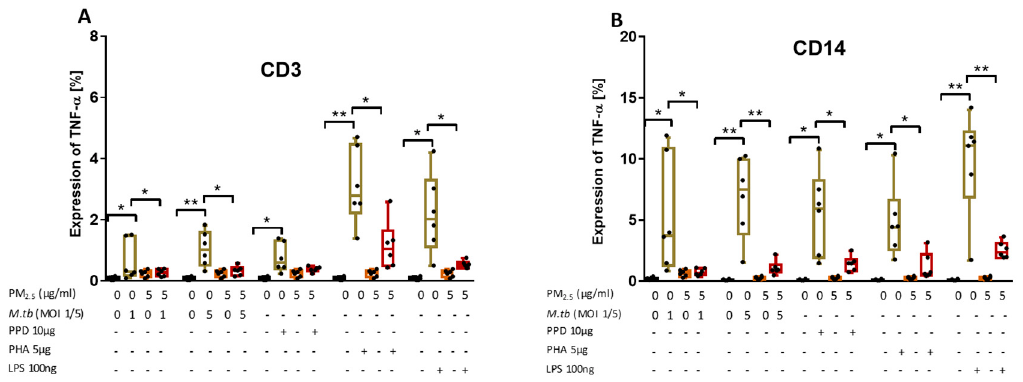
Figure 5. PM 2.5 exposure decreases M.tb-induced TNF- α expression in PBMC. (A, B) PBMC from